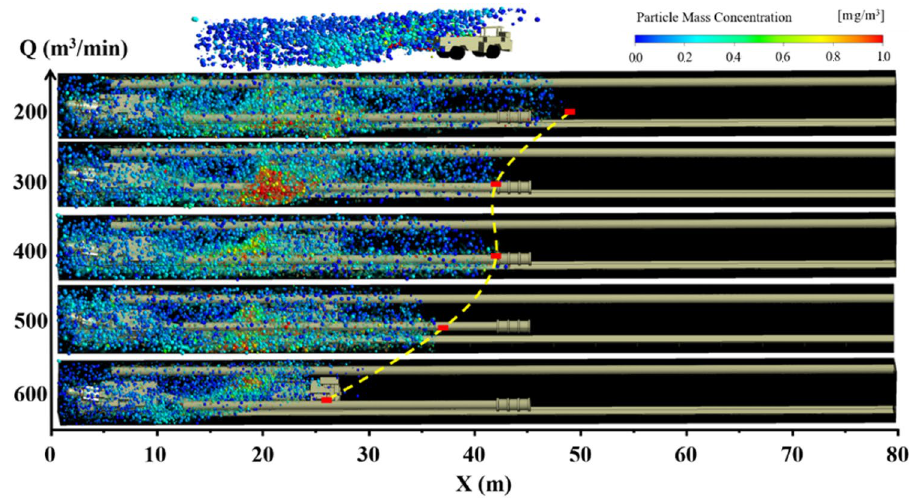
Figure 10. DPM distribution under different air volumes Q at L = 20 m.